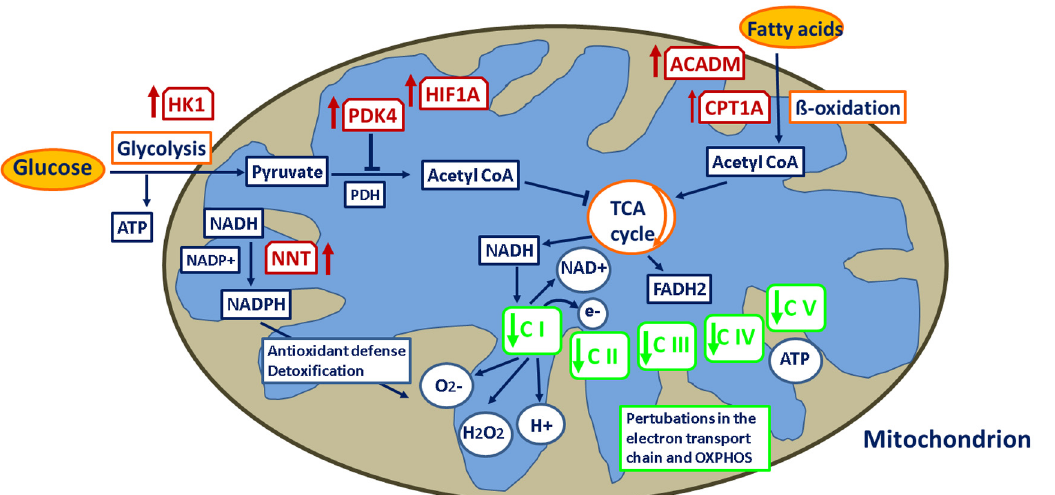
Fig 7. Metabolic switch due to virus challenge in cows vaccinated prior to calving. Loci (red-framed boxes) upregulated in response to vaccination are indicated by red arrows, loci (green-framed boxes) downregulated in response to vaccination are indicated by green arrows. CI-C V: complexes of the respiratory electron transport chain. PDK4: pyruvate dehydrogenase kinase 4, NNT: nicotinamide nucleotide transhydrogenase, CPT1A: carnitine palmitoyltransferase 1A, ACADM: acyl-CoA dehydrogenase, medium-chain, HK1: hexokinase 1, HIF1A: hypoxia inducible factor 1